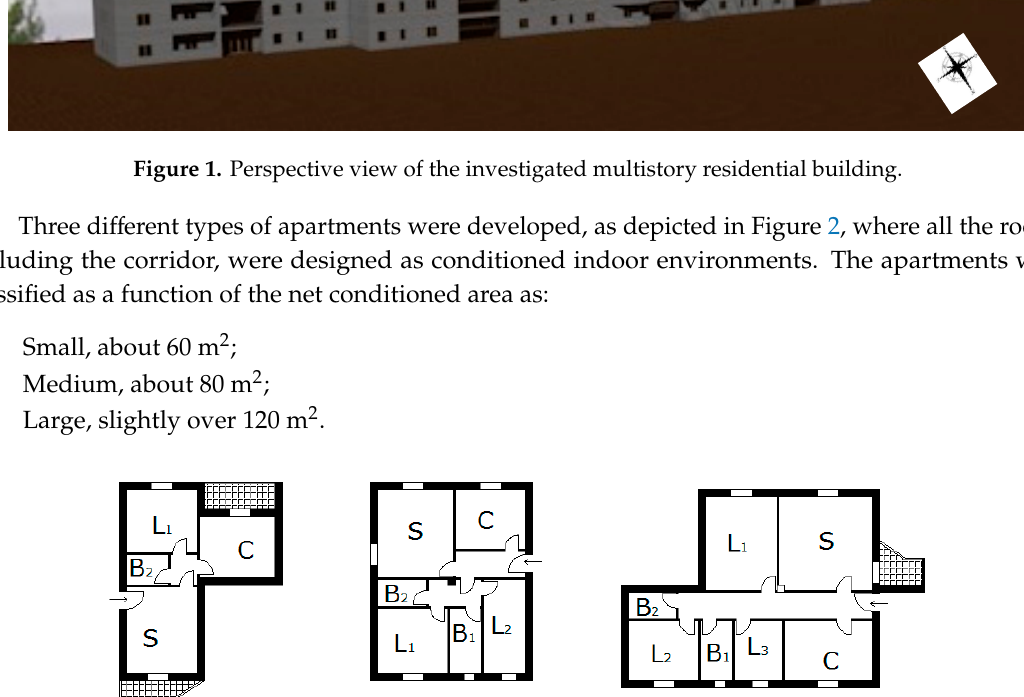
Figure 2. Typologies of apartments in the analyzed building (S: living room, B: bathroom, L: bedroom; C: kitchen).